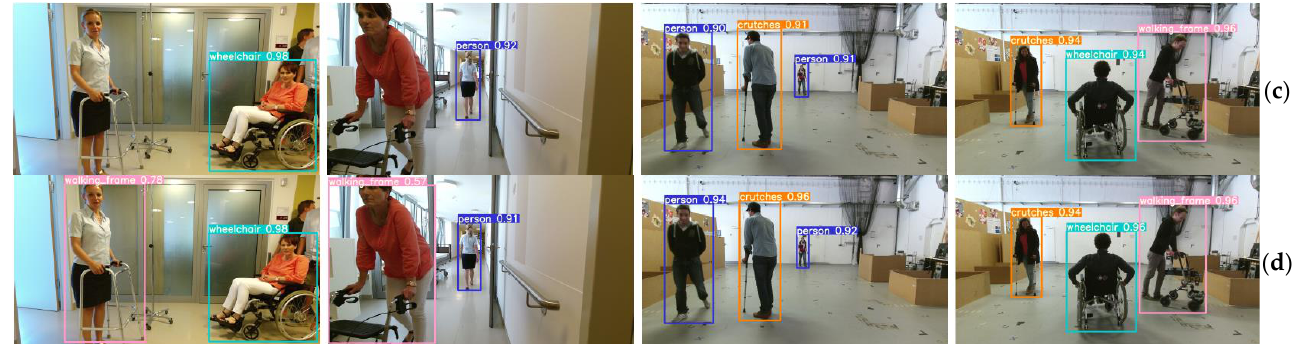
Figure A3. Detection results on 4 images from MobilityAids dataset. ( a ) Original image samples. ( b ) Experiment 1 (Hospital1) output sample. ( c ) Experiment 2 (Hospital2) output sample. ( d ) Experi- ment 3 (Pretrained_Hospital1) output sample.